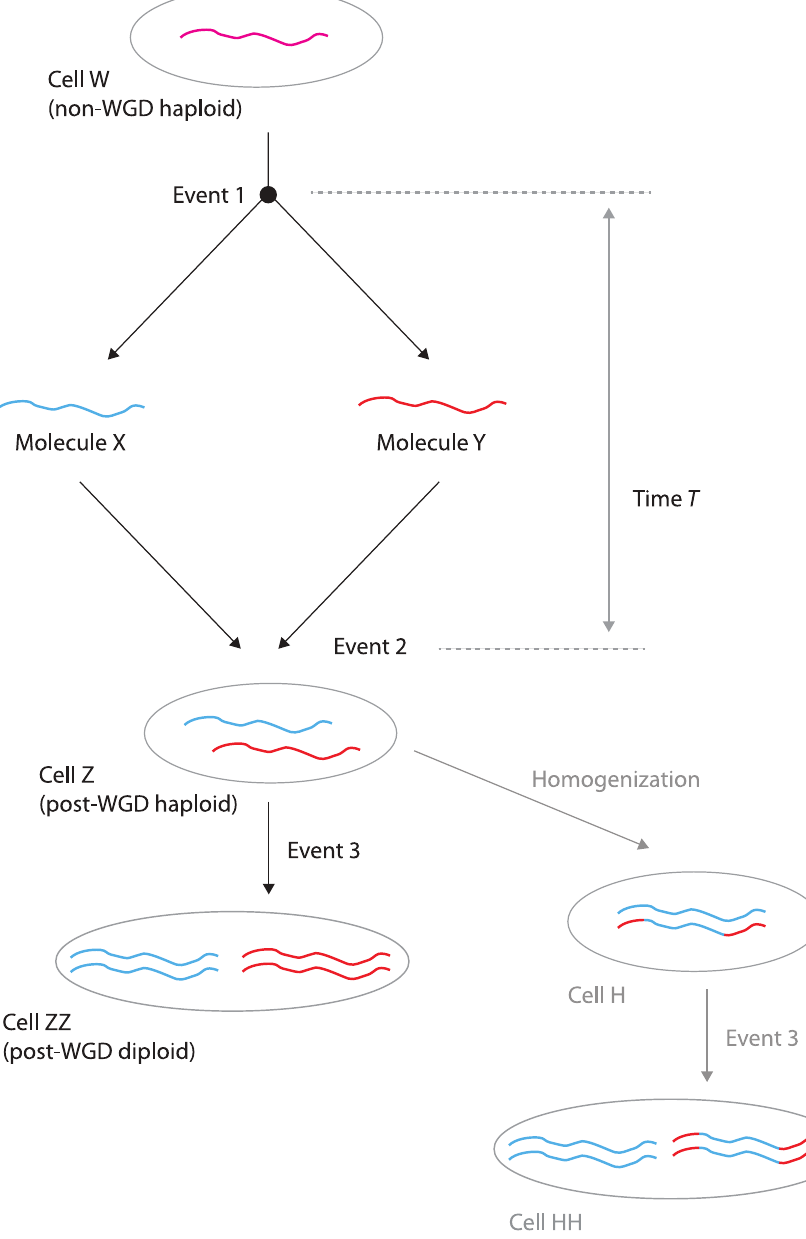
Fig 2. Tracing the history of a single chromosomal region. See text for details. In an allopolyploidization, the red and blue chromosomes are called